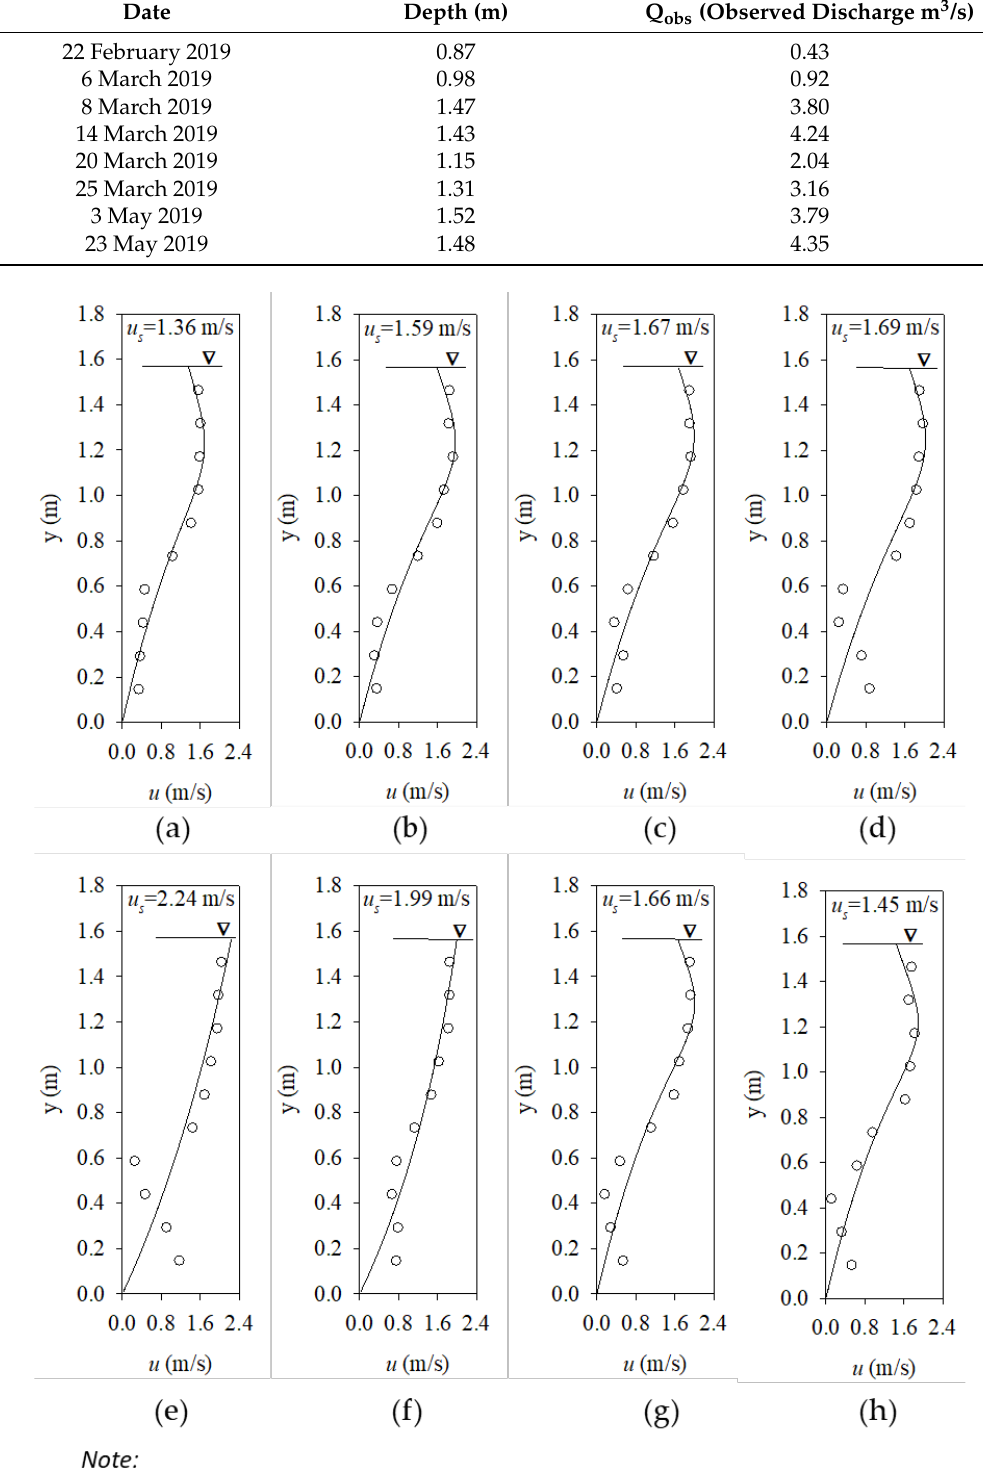
Figure 7. Subsectional velocity profile of the Run 4 in the Longen Channel. ( a ) vertical I; ( b ) vertical II; ( c ) vertical III; ( d ) vertical IV; ( e ) vertical V; ( f ) vertical VI; ( g ) vertical VII; ( h ) vertical VIII of Figure 6.